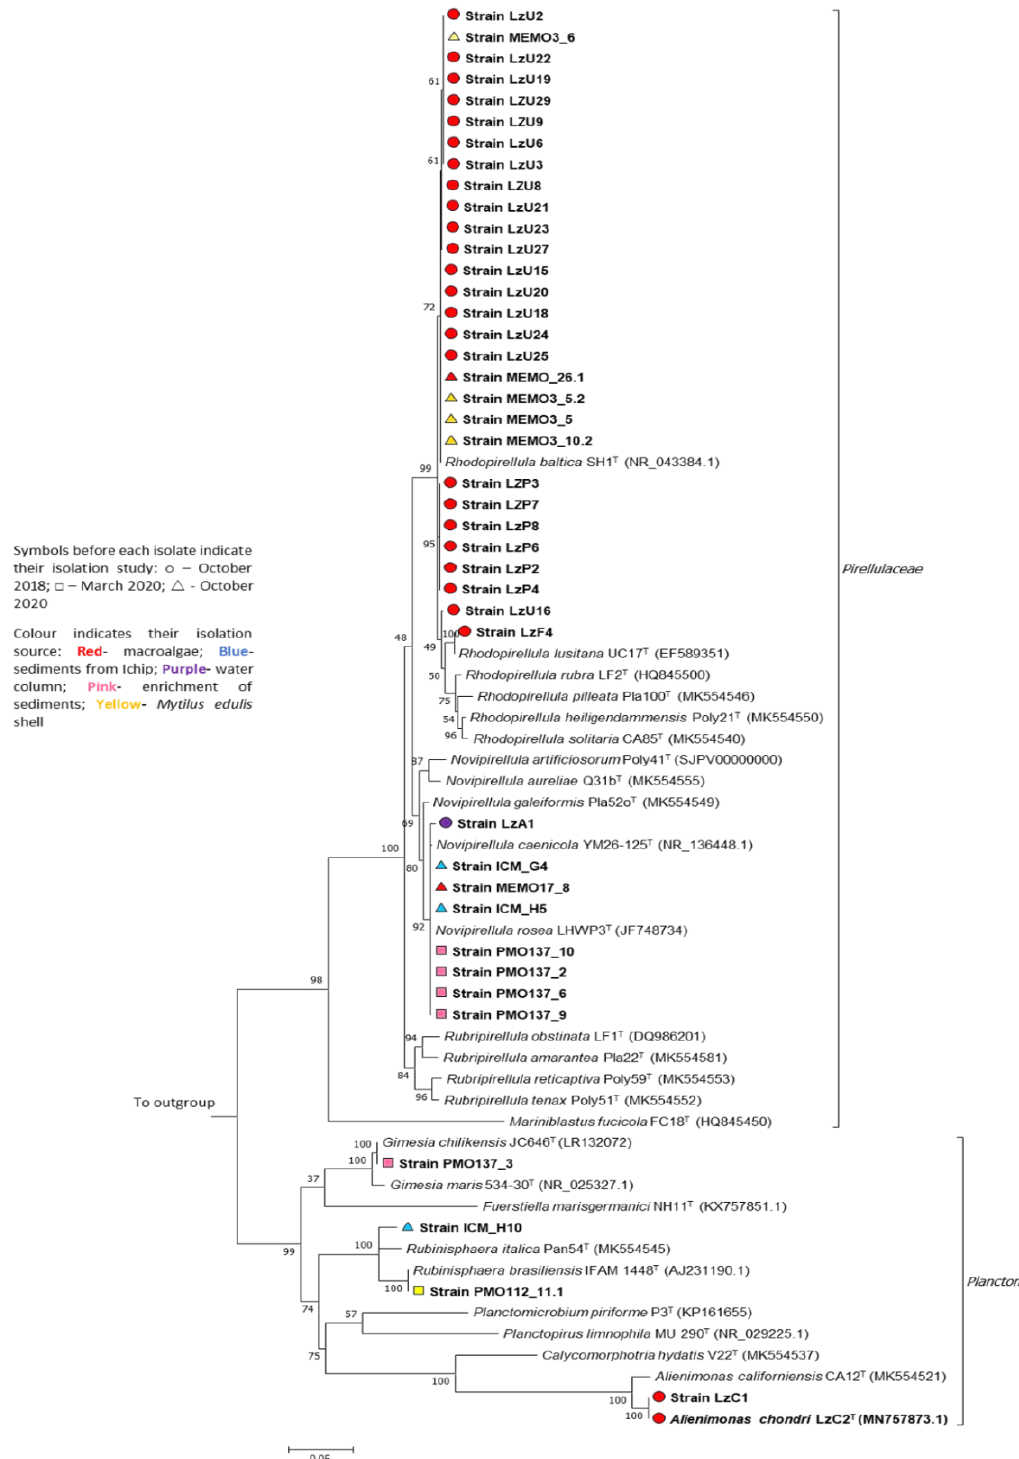
Figure 3. Phylogenetic 16S rRNA gene-based tree showing the affiliation of the isolates obtained in this study (in bold) within the phylum Planctomycetes and class Planctomycetia . The numbers on the branches refer to the percentage of trees in which the associated taxa clustered together from the total of 1000 bootstrap replications. The scale bar refers to 0.05 substitutions per nucleotide position. Members belonging to the Class Phycisphaerae were used as outgroup. Publicly available sequences from close related species type strains were obtained from the NCBI database with the respective GenBank accession numbers presented in parenthesis.